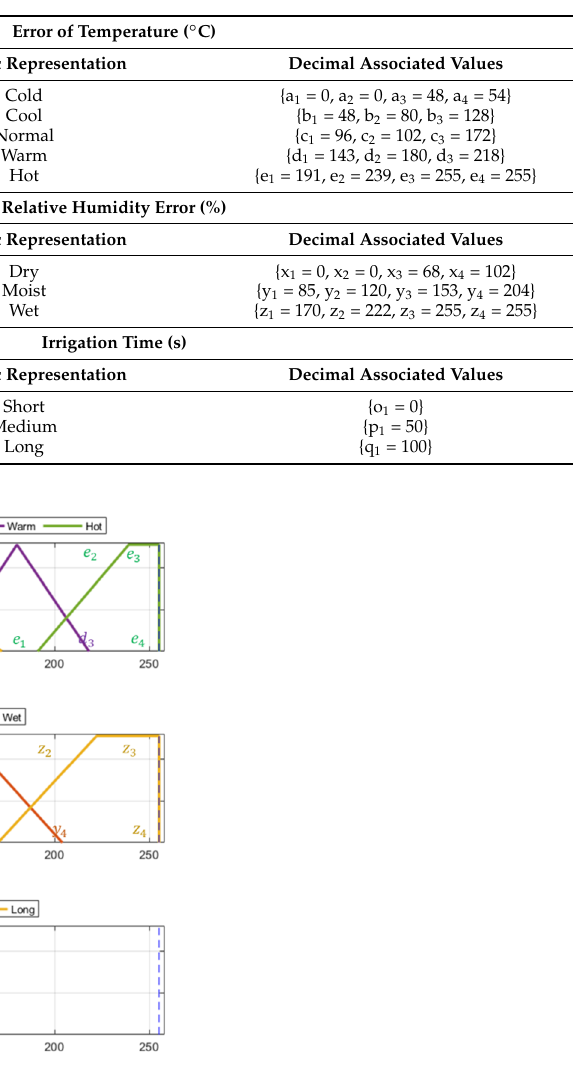
Table 2. Values associated with the parameters of environmental temperature, relative humidity, and irrigation time, which define the membership functions for the rose cultivation fuzzy logic controller.